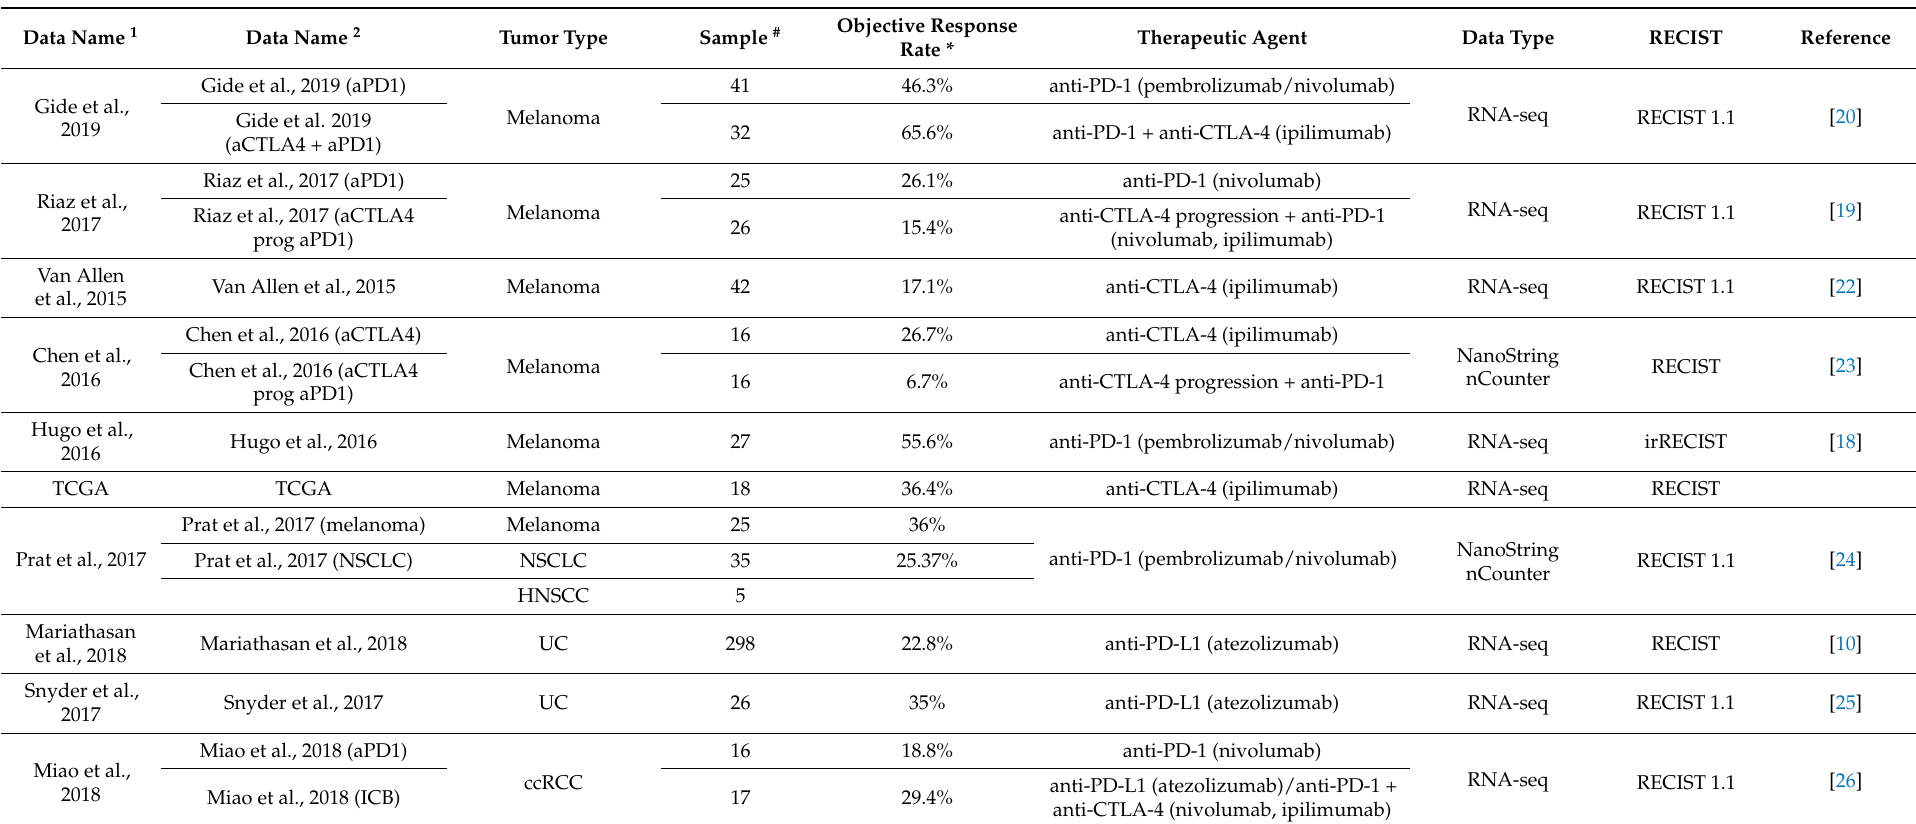
Table 1. Benchmark datasets for the evaluation in different cancer types and ICB therapy